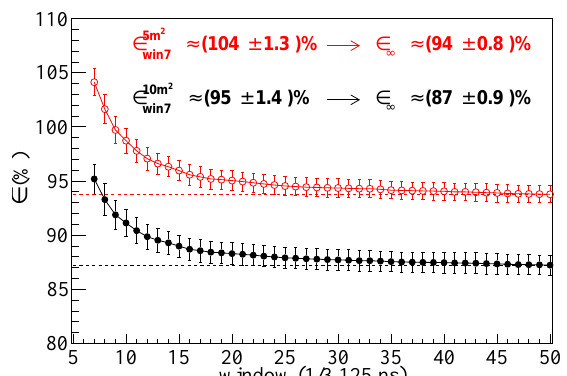
Figure 3: Laboratory measurement of the area-dependent module e ffi ciency for 5 and 10 m 2 modules as a function of the applied window size in the reconstruction procedure.